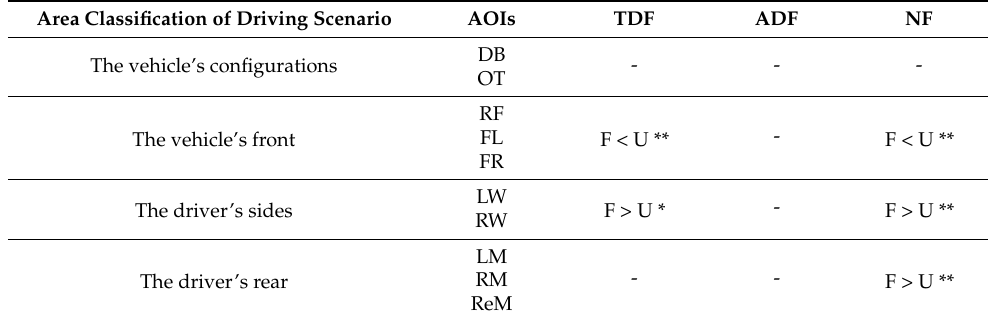
Table 4. Four classifications into which AOIs were divided from the drivers’ perspective and the comparison between unfamiliar drivers and familiar drivers for each